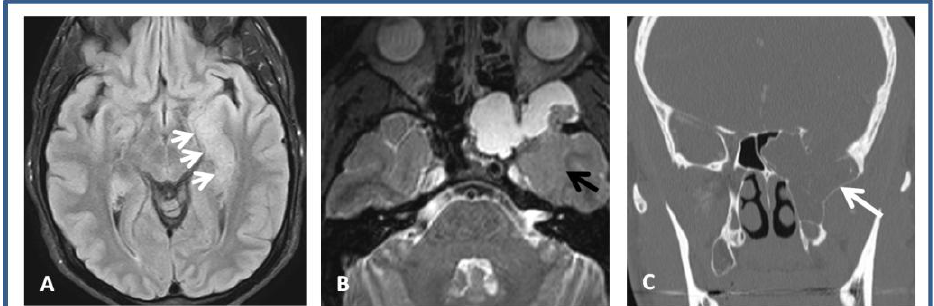
Figure 1. Preoperative brain imaging. ( A ) Axial FLAIR sequence showing increased signal in the left medial temporal lobe (small white arrows). ( B ) Axial T2 sequence shows herniated intracranial contents extending through the skull base defect. There is thickening of the regional cortex (black arrow). ( C ) Coronal CT maxillofacial showing the large left temporo-sphenoidal encephalocele (white arrows).